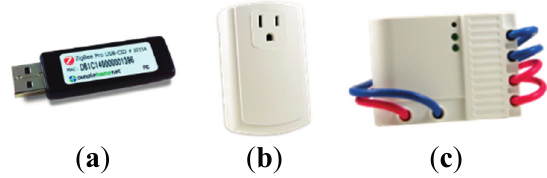
Figure 8. ZigBee devices. ( a ) Transceiver; ( b ) Power Meter; and ( c ) On/Off Power